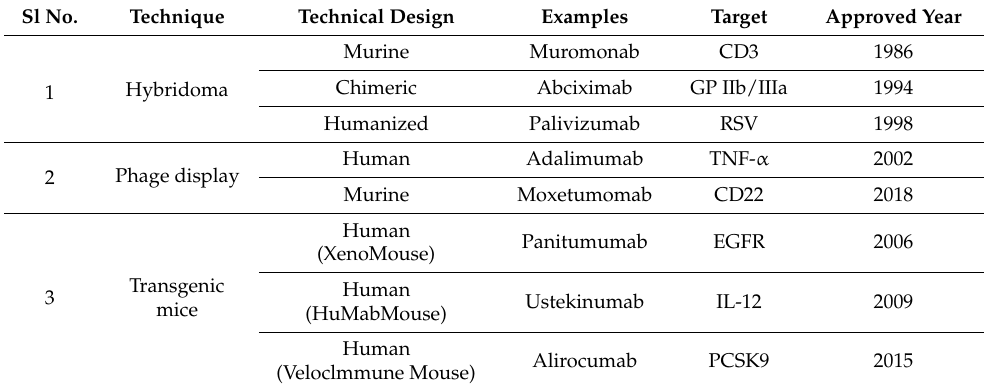
Table 2. Chronology of technical innovations in the development of monoclonal antibodies [28,29]. Sl